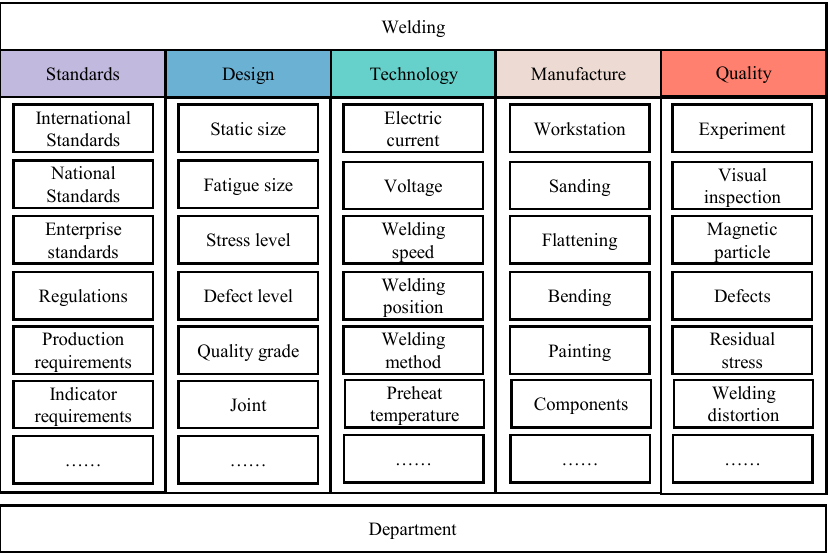
Figure 1. Description of bogie structure. 1—Framework components; 2—Series II transverse shock absorbers seats; 3—Crossbeam components; 4—Spring mounts; 5—Lifting seat; 6—Side beam com- ponents; 7—Air spring seats; 8—Axle box locator; 9—Series I pendant locators.